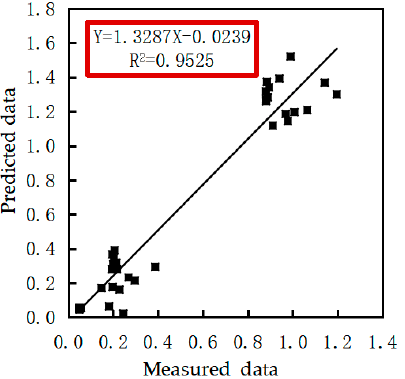
Figure 10. The predicted and the measured values of threshing performance.